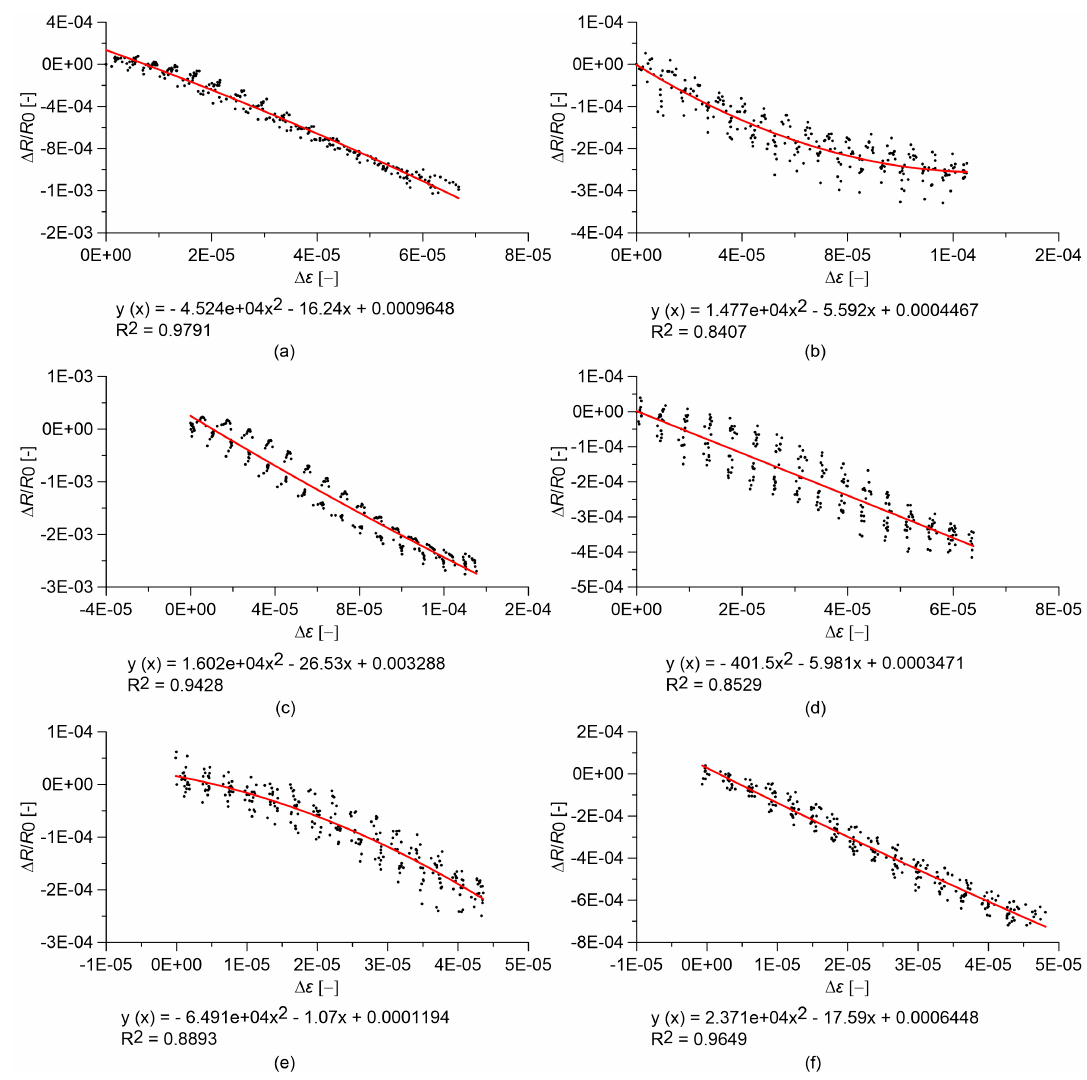
Figure 5. Relative change in electrical resistance versus applied strain of nanocomposite cement paste specimens under quasi-static compression loads. In the plots, R 0 is the electrical resistance value with a preload of 0.5 kN, and equations of quadratic regression lines are reported: cured paste with ( a ) 0.00% MWCNTs; ( b ) 0.25% MWCNTs; ( c ) 0.50% MWCNTs; ( d ) 0.75% MWCNTs; ( e ) 1.00% MWCNTs; ( f ) 1.50% MWCNTs.